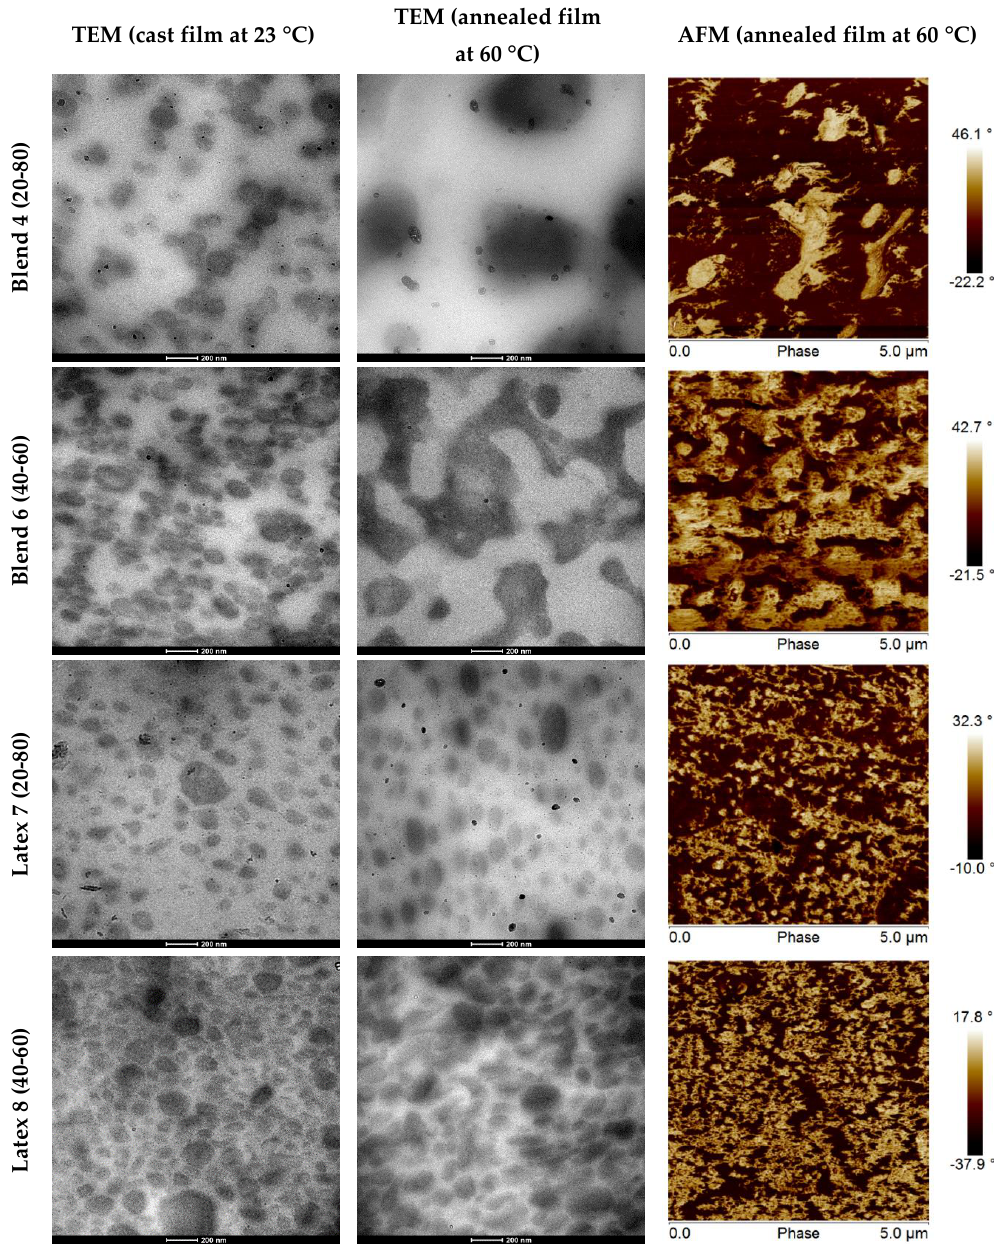
Figure 3. Cross-section TEM micrographs of the as-cast adhesive films at 23 °C (on the left side) and the TEM (in the middle) and AFM (on the right side) of the annealed adhesive films at 60 °C after cooling. The scale bar of TEM and AFM images are 200 nm and 5 µm, respectively.